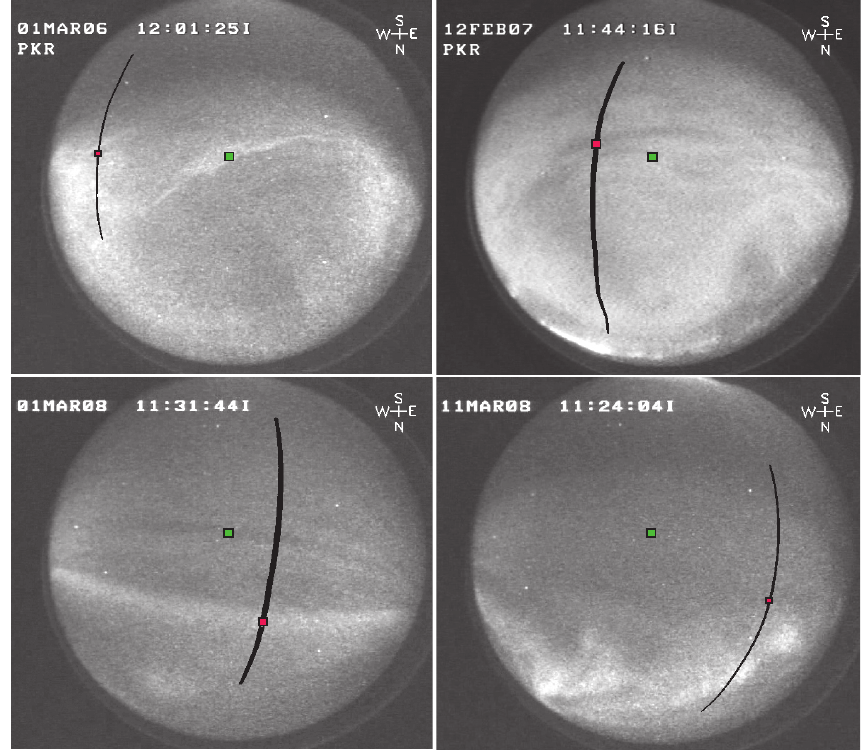
Fig. 1. Representative all-sky images for each overpass. Upper-left: 1 March 2006; upper-right: 12 February 2007; lower-left: 1 March 2008, and lower-right: 11 March 2008. The dark line on each image indicates the Reimei footpoint over the interval of interest, while the red square indicates the footpoint position at the time of the image. The green squares denote the position of the magnetic zenith. North is down and East is to the